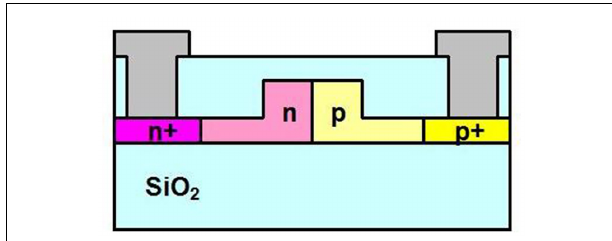
FIGURE 1 | Diagram showing the cross section of the silicon optical phase modulator with PN junction positioned in the center of the waveguide. Lower SiO 2 layer is 2 µ m thick. Silicon overlayer is 220nm thick, with slabs etched to a thickness of 100nm to form the rib waveguide. The top SiO 2 layer is 1 µ m thick. Finally the electrodes are approximately 1.3 µ m